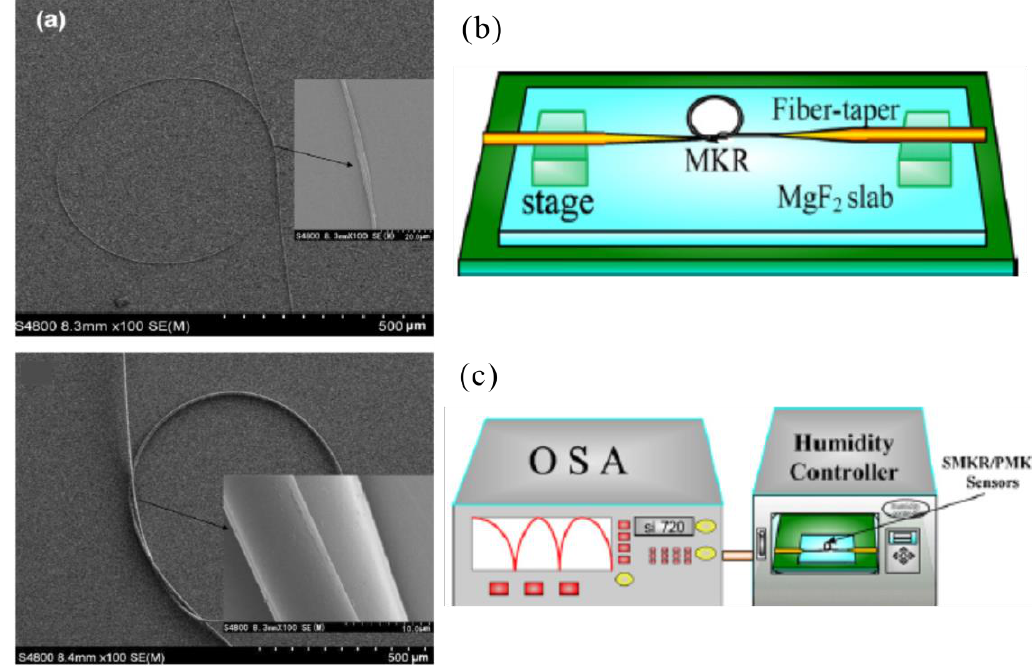
Figure 9. ( a ) SEM image of the single mode fibers (SMF)/polymer fiber-based micro-knots; ( b ) Sensing structure of micro-knot sensor; ( c ) experimental setup for humidity sensing [147].